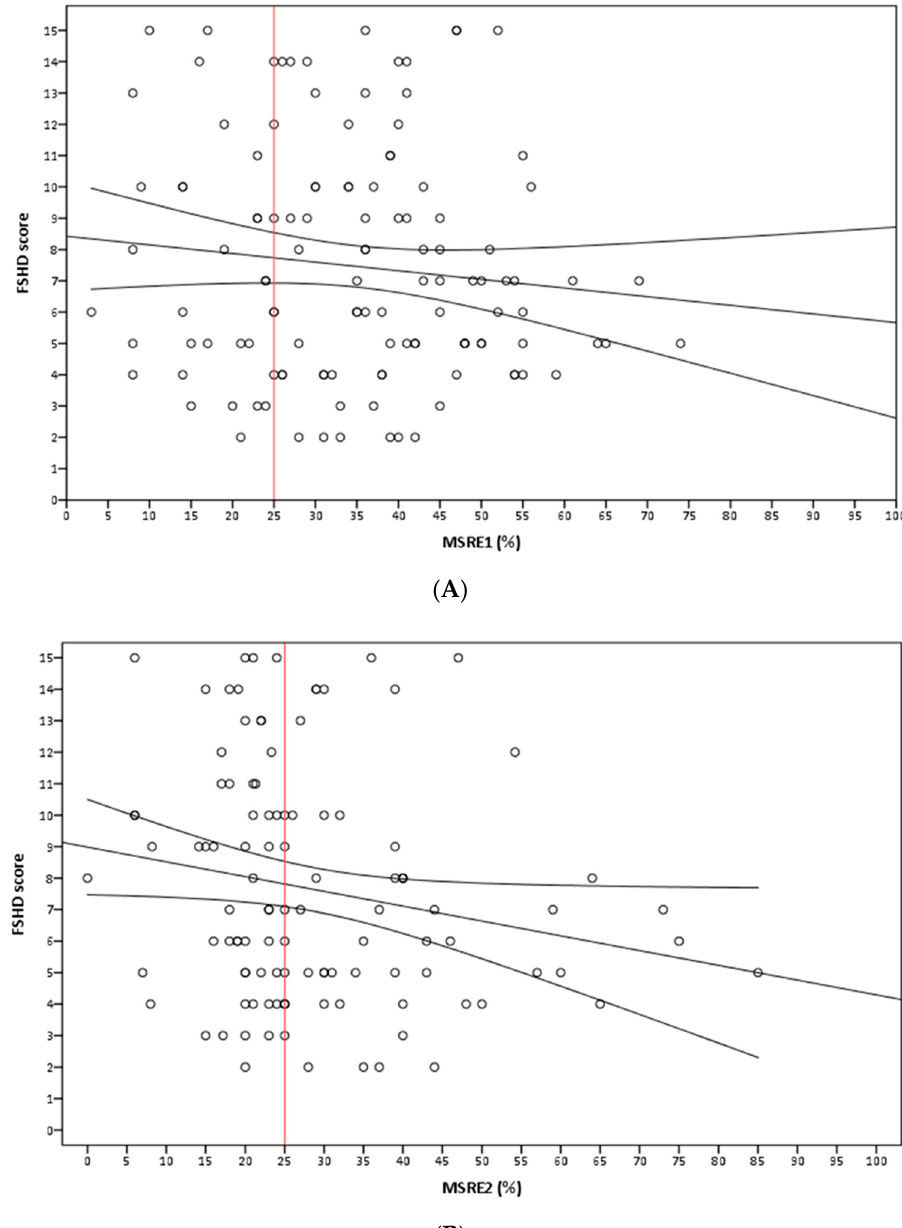
Figure 1. Assessment of DNA methylation level in facioscapulohumeral muscular dystrophy (FSHD) index cases using MRSE1 (A) and MRSE2 (B) approaches: ( A ) The crude relationship between the